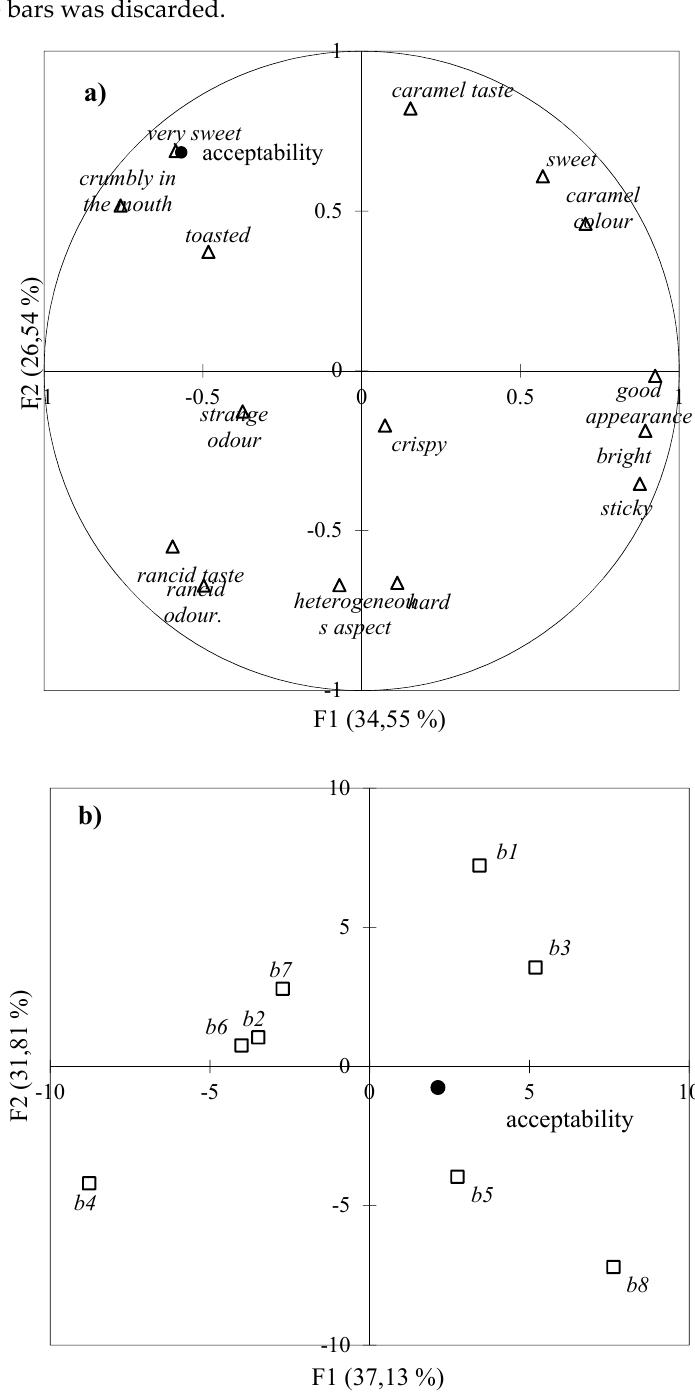
Figure 2. Representation of F1–F2 factors of the principal component analysis applied to the data of the second sensorial analysis—ingredient selection. ( a ) Variables: sensory attributes ( ∆ ), supplementary variable: acceptability ( ● ). ( b ) Samples ( □ ), supplementary variable: acceptability ( ●